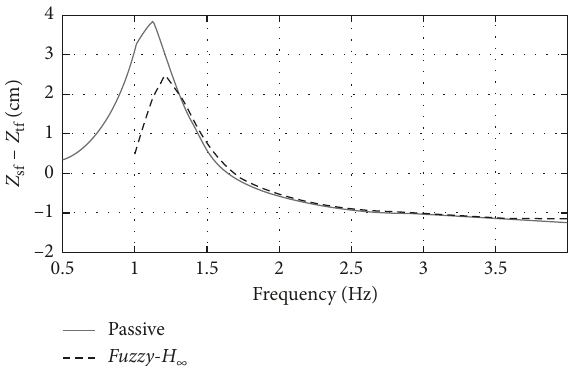
Figure 18: Front suspension deflection (cm).